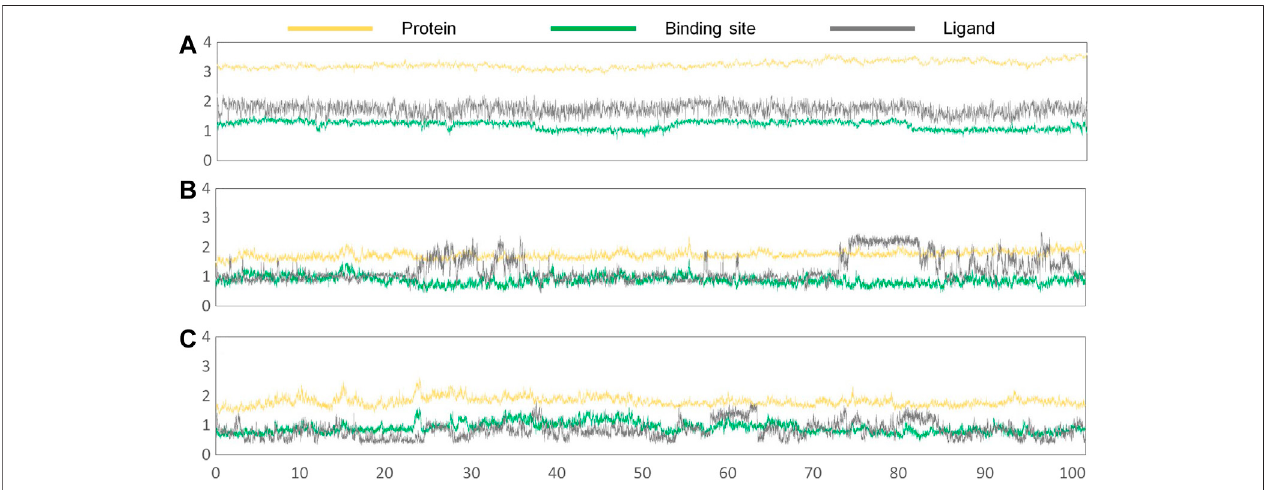
FIGURE 5 | RMSD values of the protein receptor (yellow), ligand (deep gray), and binding sites (green) of the constructed systems as the function of time of the second simulation: (A) Compound 7i system; (B) ge fi tinib system; (C) erlotinib system.